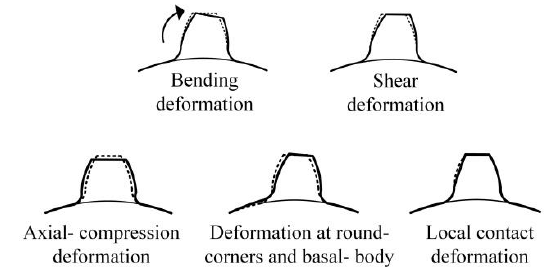
Figure 7. The contact deformation of involute teeth.